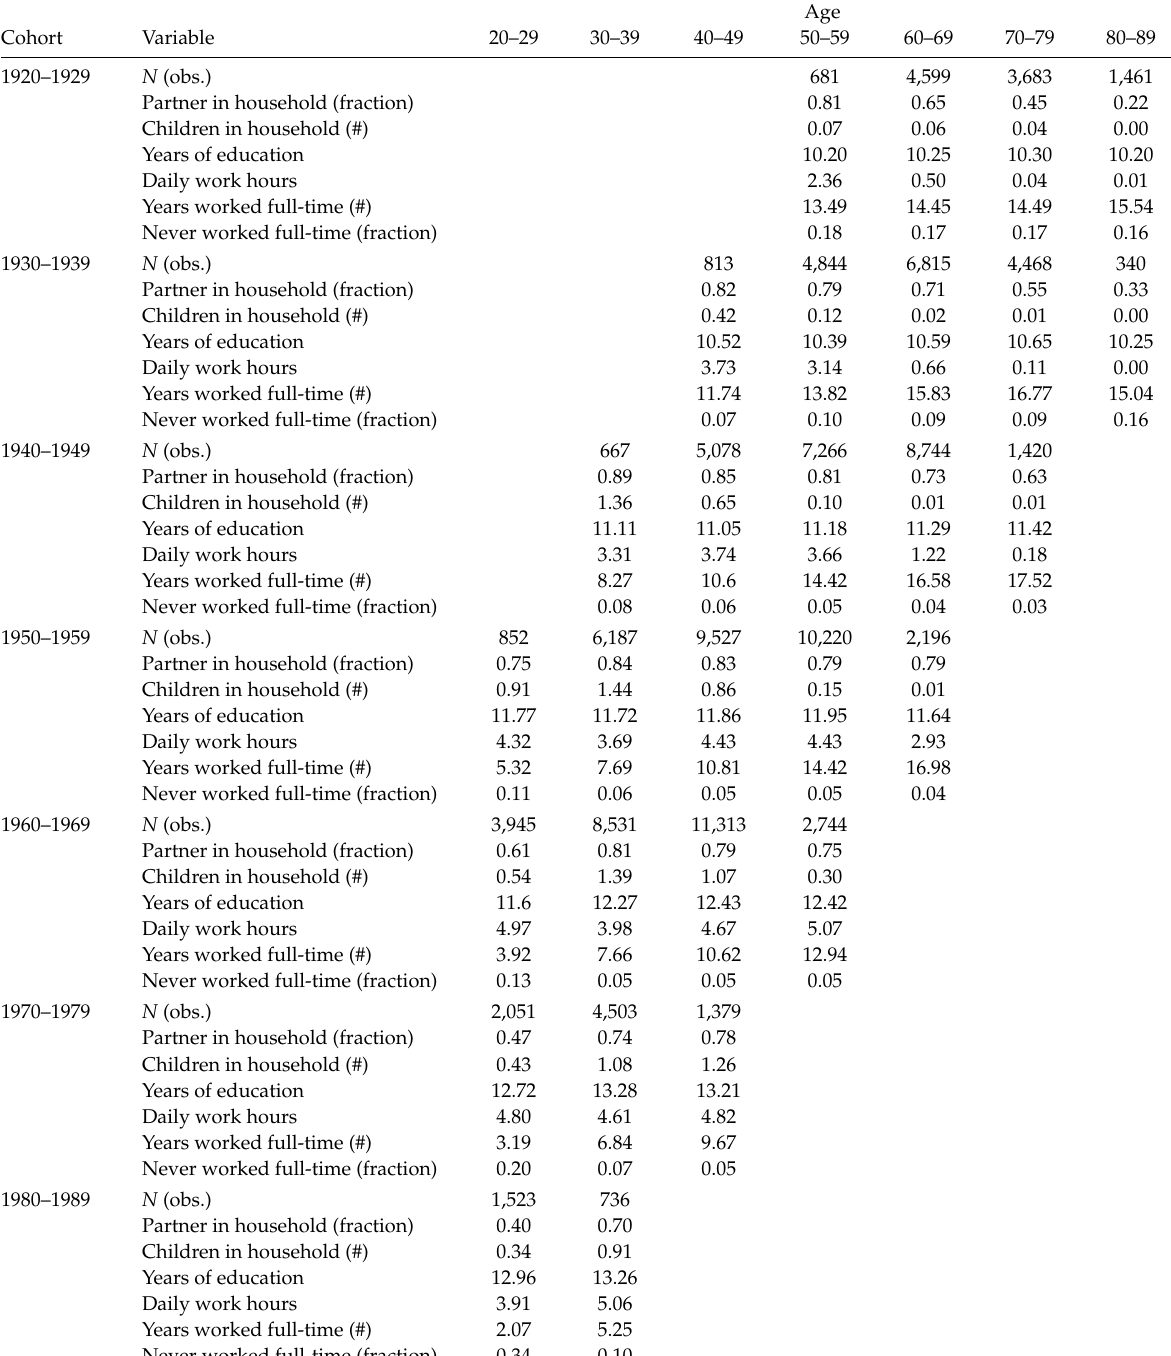
Table 1: Descriptive statistics